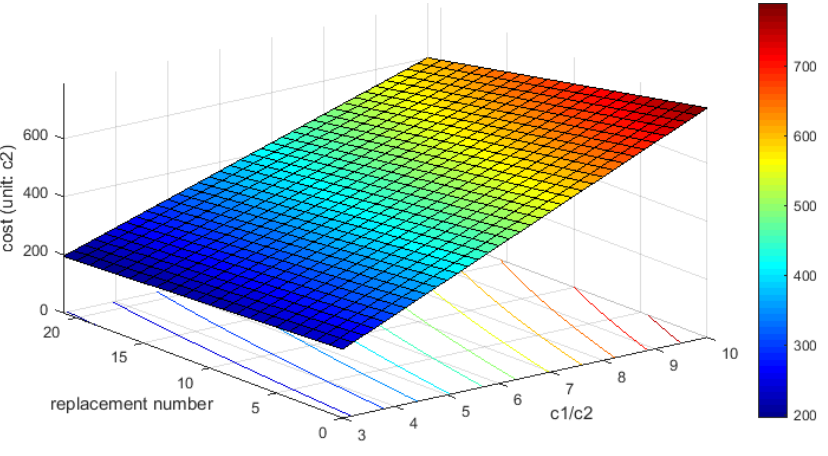
Figure 6. The cost of different combination schemes based on the price of inductive loop.